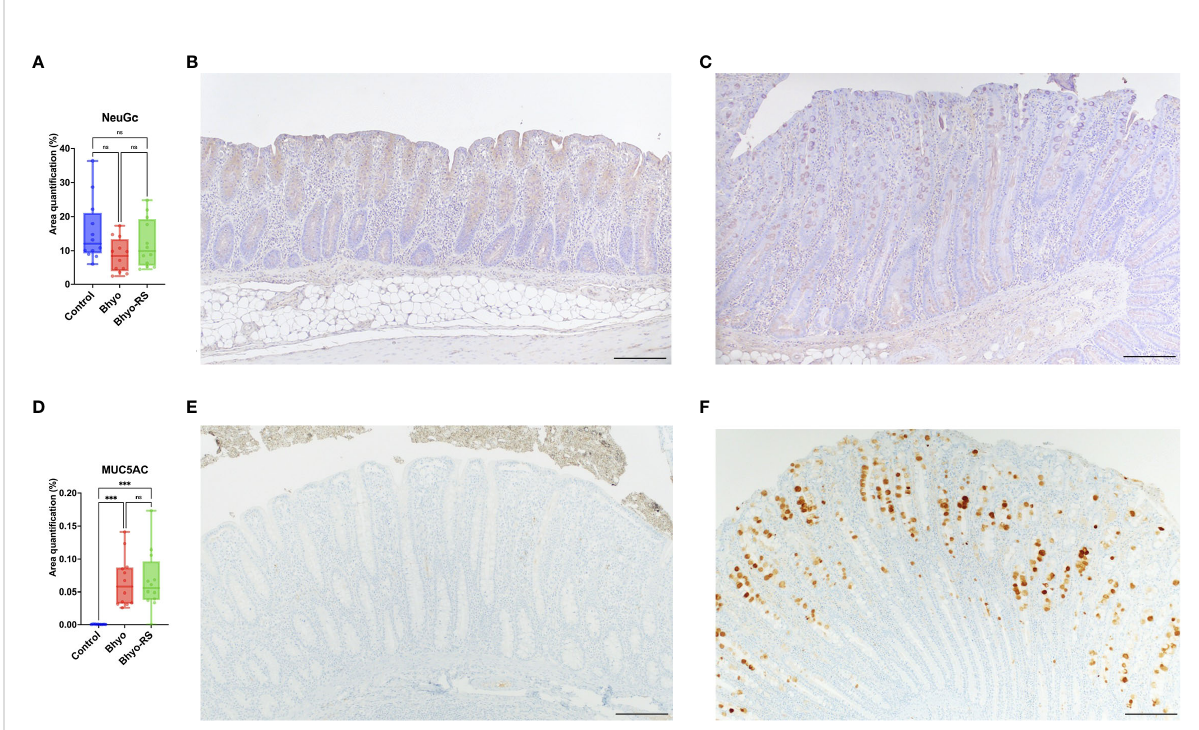
FIGURE 4 No signi fi cant difference in the total expression of NeuGc was detected between the three groups (A) . Controls slightly tend to show abundant positive staining within goblet cells and epithelial cytoplasm (B) , whereas positivity in pigs infected with B.hyodysenteriae was often presented within crypt lumens and less in the cytoplasm (C) . MUC5AC expression was signi fi cantly different between the three groups ( D , P < 0.05). There was a marked de novo expression of MUC5AC in the Bhyo and Bhyo-RS (F) groups compared to the controls ( E , P < 0.05). Bar = 200 µm. ***, P ≤ 0.001; ns, not signi fi